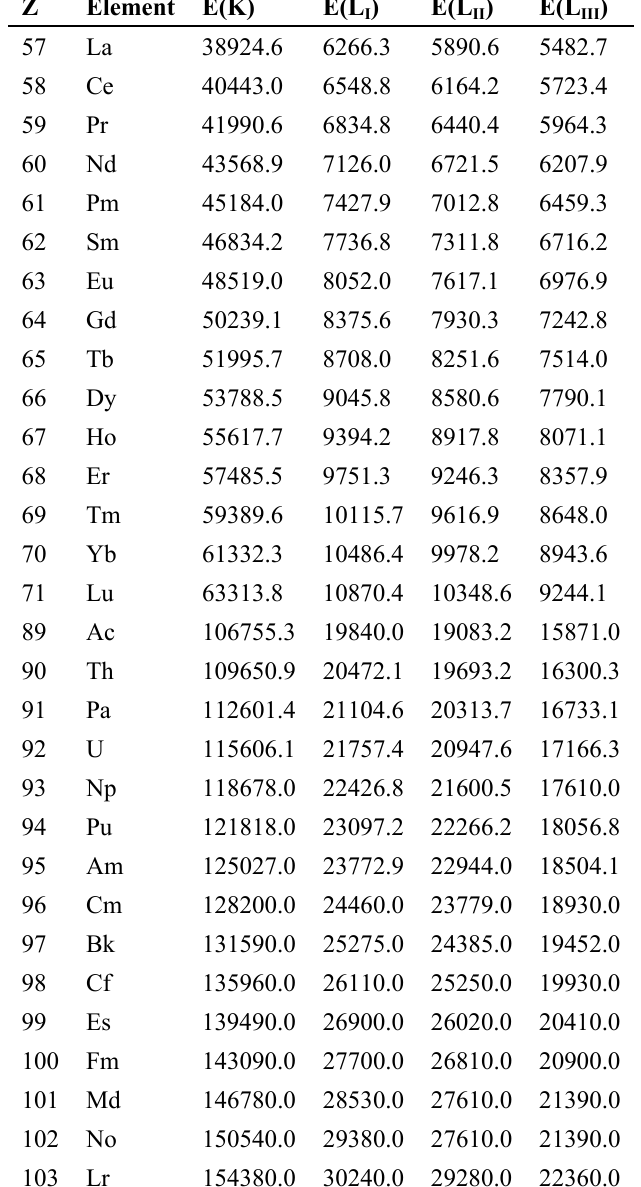
Table 3. X-ray K- and L-edge energies of the actinide/lanthanide elements in eV, data are from